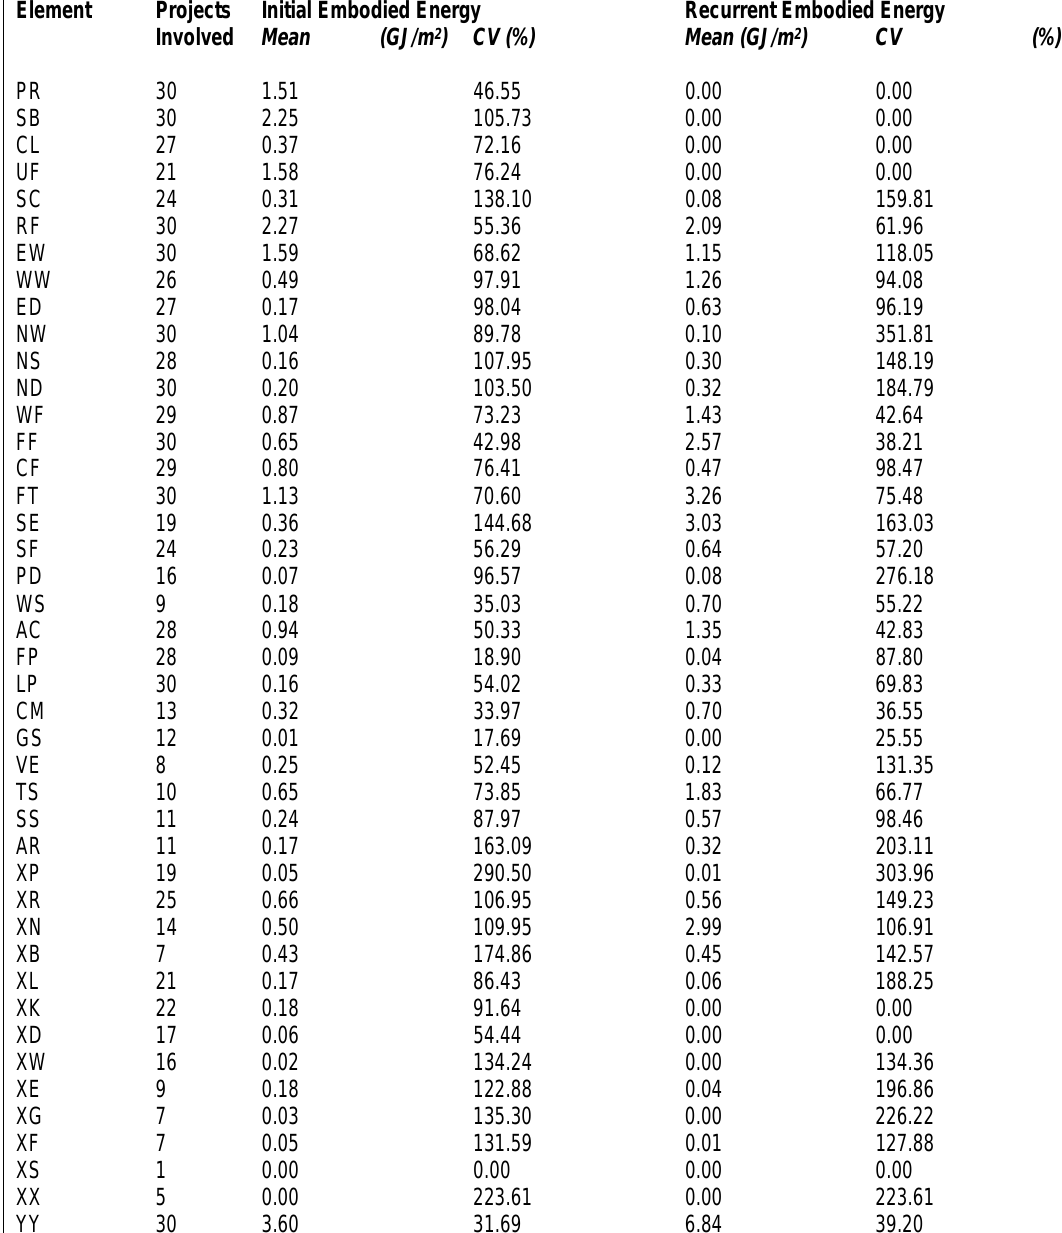
Table 3: Statistical Summary for Embodied Energy by Element ( Langston